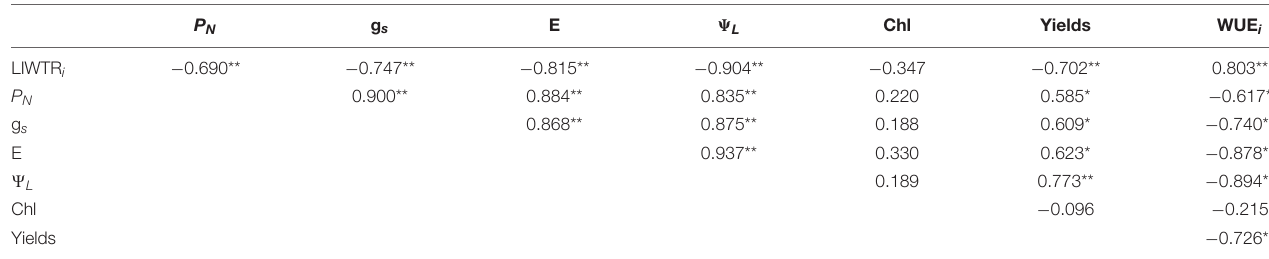
Means (n = 5) in the same row followed by different letters differ significantly at p ≤ 0.05, according to one-way ANOVA (standard error is shown in parenthesis). TABLE 6 | The Pearson correlation coefficients among leaf intracellular water transport rate (LIWTR i , M (cid:127) N − 1 ), net photosynthetic rate ( P N , µ mol m − 2 s − 1 ), stomatal conductance